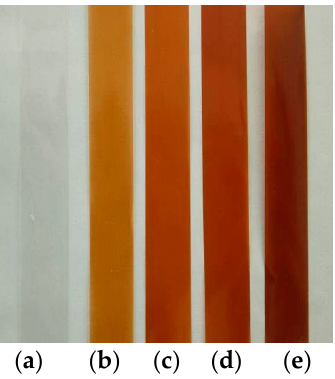
Figure 1. The shape of the composite materials. ( a ) PVA; ( b ) 10% alkali lignin/PVA; ( c ) 15% alkali lignin/PVA; ( d ) 20% alkali lignin/PVA; ( e ) 25% alkali lignin/PVA.